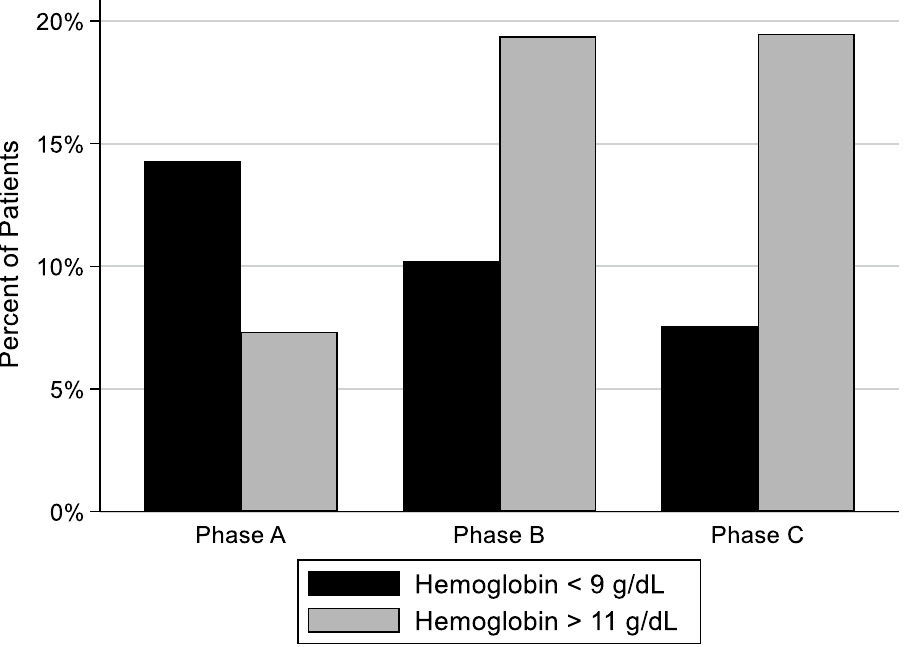
Figure 1. Percentage of patients with Hb < 9 (below target) and Hb > 11 g/dL (above target) in each phase.